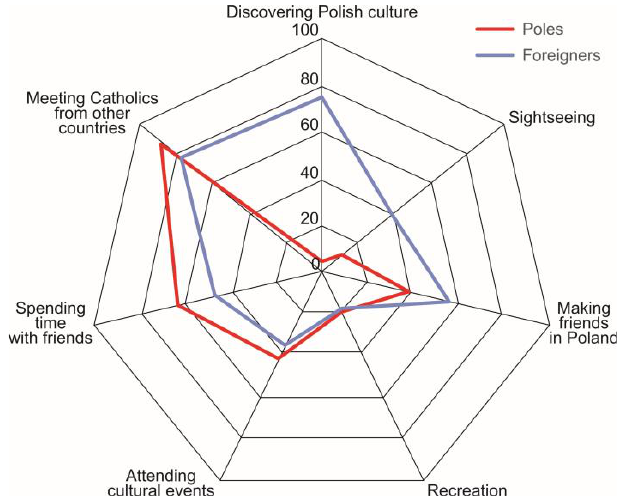
Figure 5. Non-religious purposes of respondents’ participation in World Youth Day. (Source: authors, based on a survey).